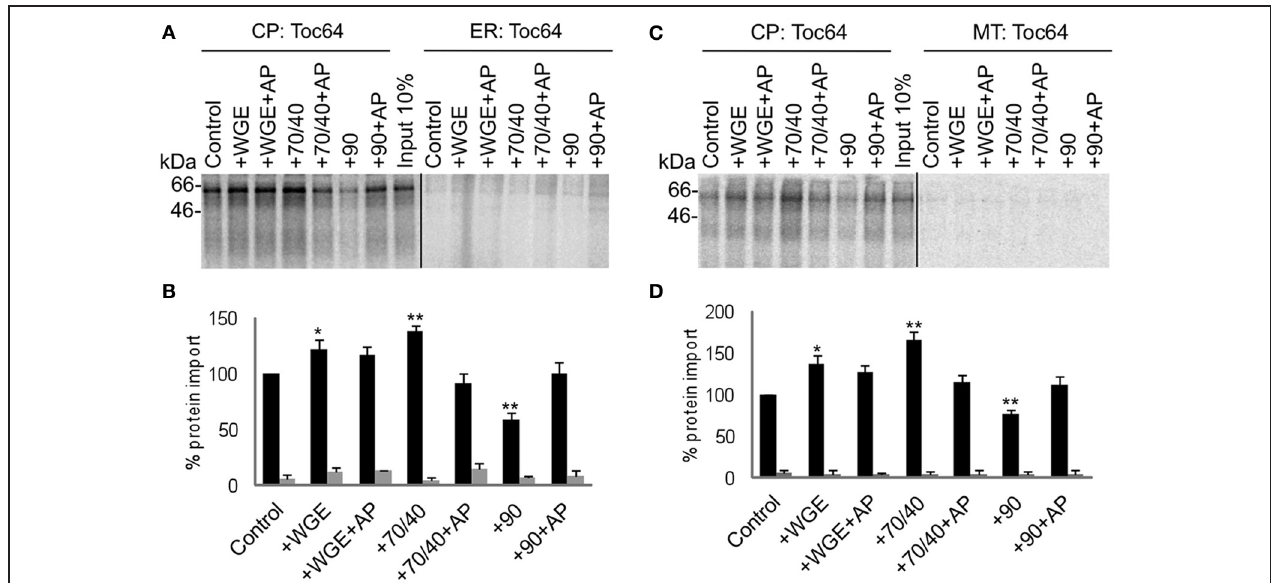
FIGURE 6 | Toc64 targets to chloroplasts efficiently and selectively under a wide range of cytosolic conditions. (A) Radio-labeled Toc64 protein derived from RNCs was incubated in a competitive targeting assay with chloroplasts (CP) and ER, with the addition of cytosolic components as indicated; control is buffer only, WGE is wheat germ extract, chaperones (Hsp) are indicated by their numbers (70/40 or 90), and AP represents apyrase treatment. Membranes were refractionated and washed with carbonate prior to analysis by SDS-PAGE. 10% of protein input is shown, and the protein molecular weight markers are indicated in kDa. (B) Quantification